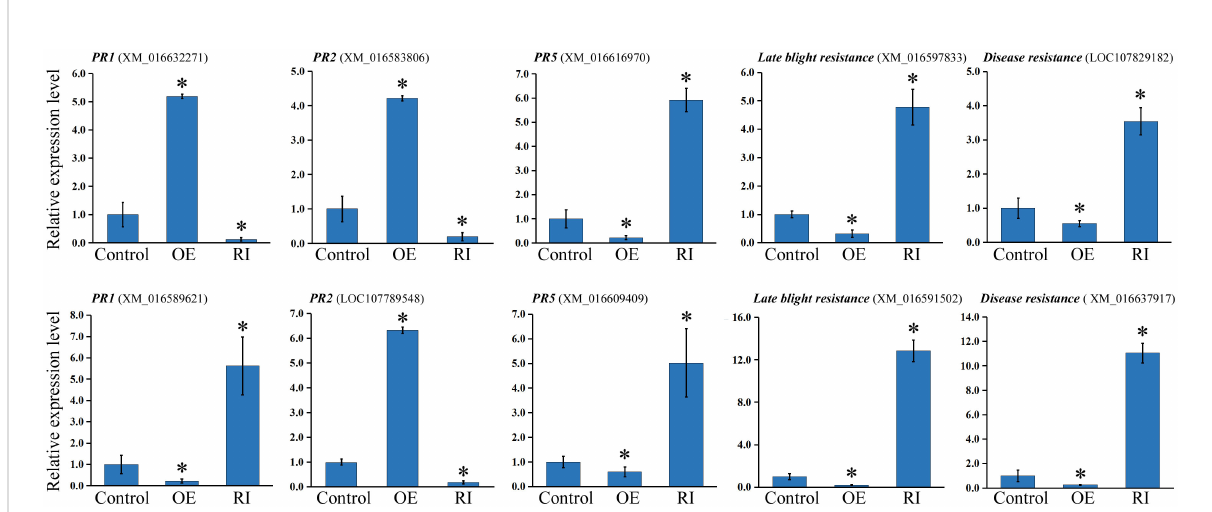
FIGURE 6 Relative expression of pathogen resistance genes in control, NtbHLH49 -OE (OE) and NtbHLH49 -RI (RI) plants. Tobacco Actin gene was used as an internal control. The expression level of each gene in control plant was set as “ 1 ” . Each value is the average (±SD) of three independent transgenic lines. Asterisks indicate signi fi cant difference from control (Student ’ s t -test; P <